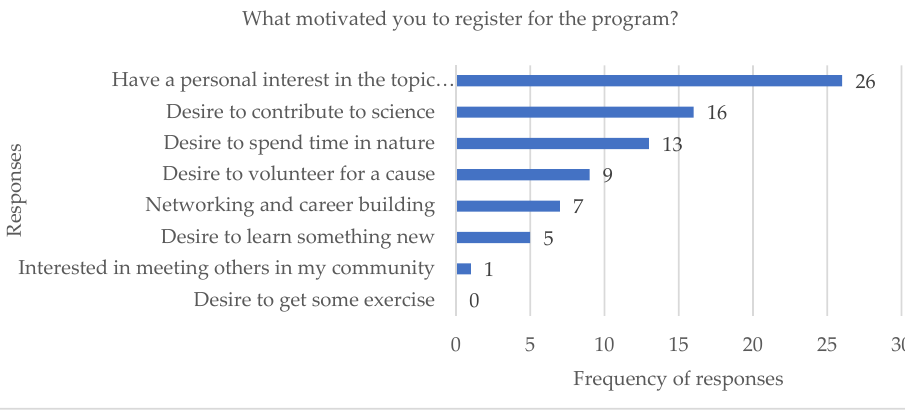
Figure 5. Survey responses depicting the motivations of surveyed participants when asked the multiple choice question: “What motivated you to register for the program?”.